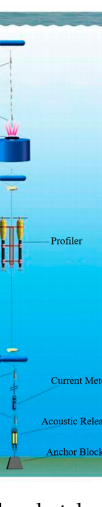
Figure 1. The sketch of the mooring system of a vertical